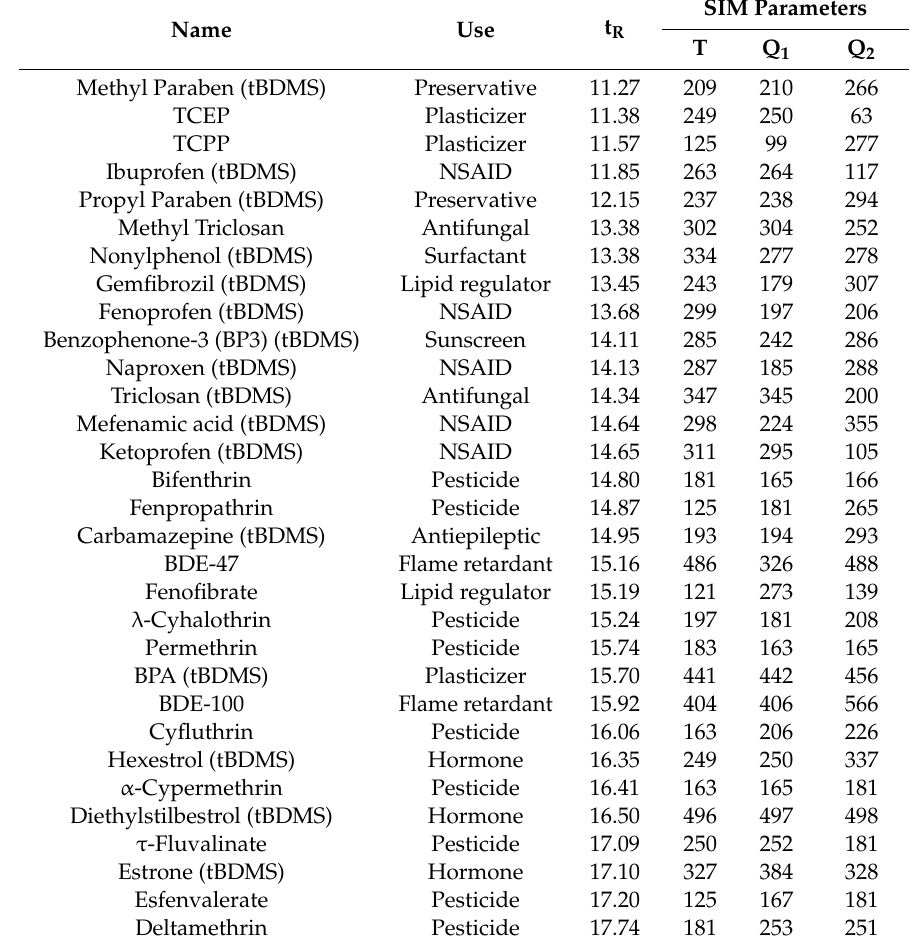
Table 1. Use, retention times and mass spectrometric parameters of the studied